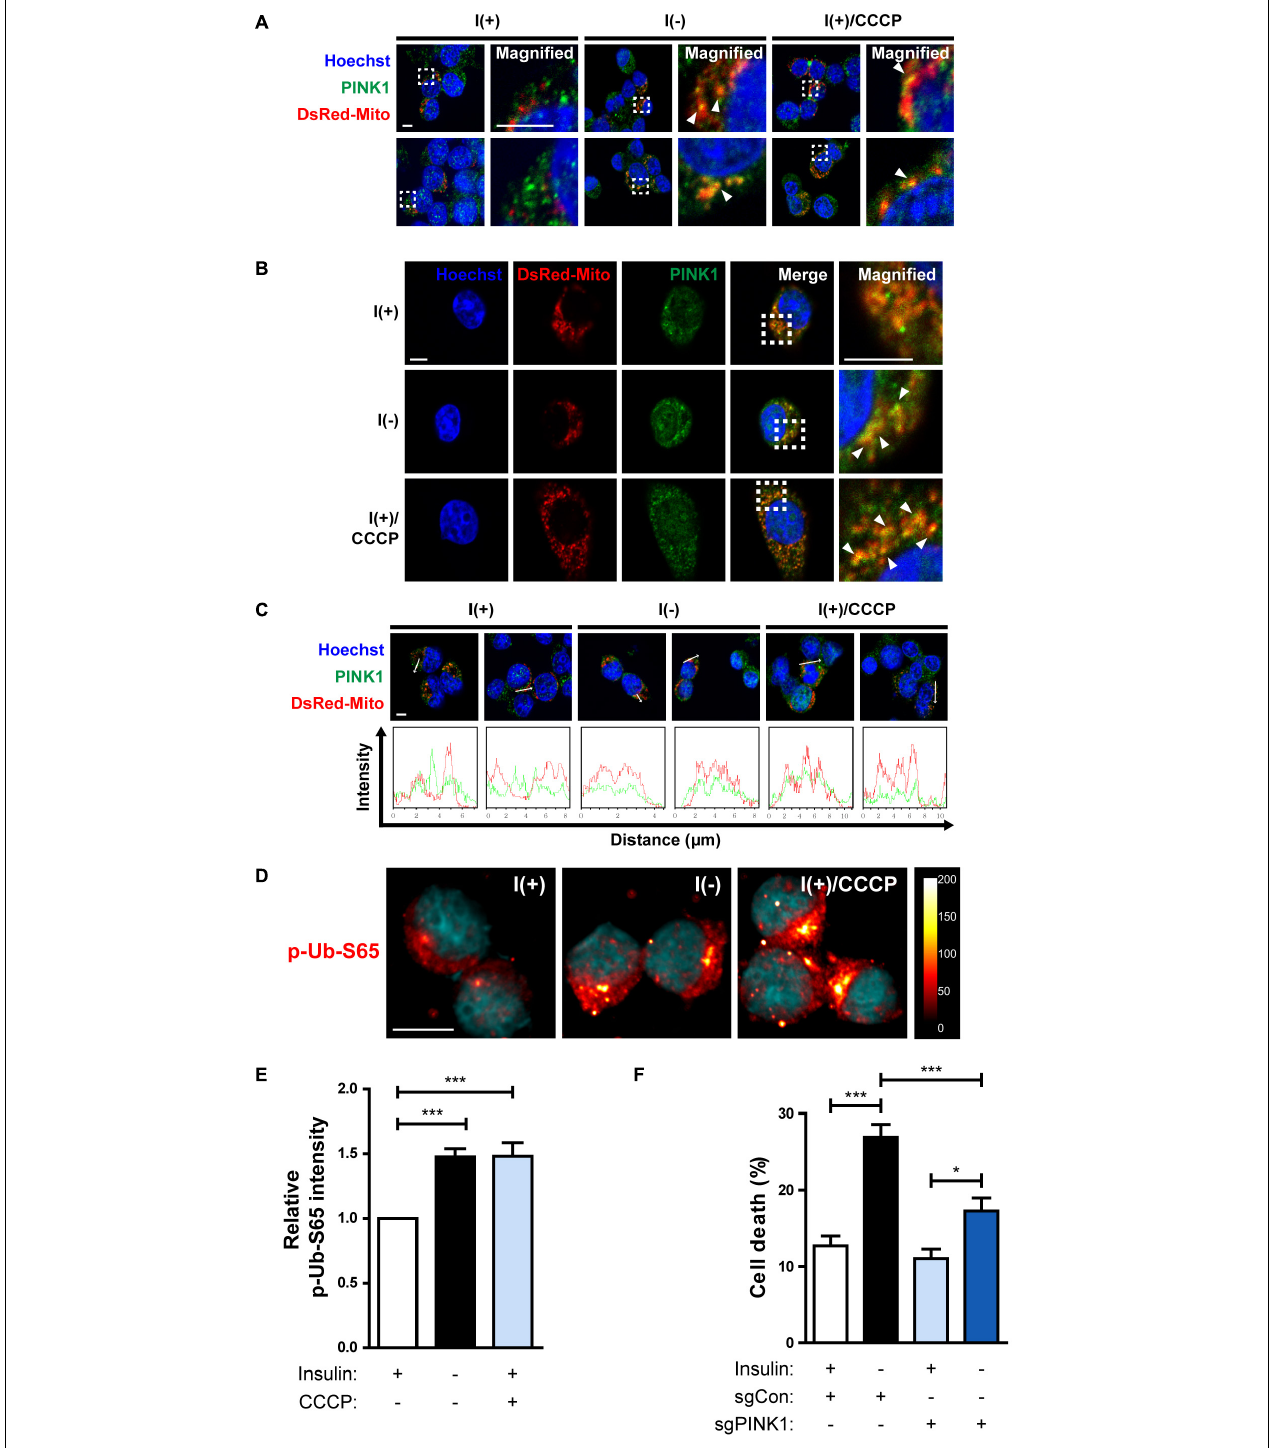
FIGURE 7 | HCN cells undergo PINK1/Parkin-dependent mitophagy following insulin withdrawal. (A,B) An increase in colocalization of PINK1 and mitochondria after insulin withdrawal for 24 h. Arrowheads indicate DsRed-Mito and PINK1 colocalization. Scale bars, 5 µ m. (C) Intensity profile graphs of PINK1 and DsRed-Mito. Scale bar, 5 µ m. (D) An increase in the level of p-Ub-S65 after insulin withdrawal for 24 h. Cells were treated with CCCP (10 µ M) for 0.5 h as a positive control of mitophagy. Blue staining indicates Hoechst, and red staining indicates p-Ub-S65. Intensity is indicated in arbitrary units. Scale bar, 10 µ m. (E) The mean intensity of p-Ub-S65 was quantified using ImageJ software ( n = 33 cells for I( + ), 38 cells for I( − ), 46 cells for I( + )/CCCP from 3 independent experiments). (F) Cell death rates of sgCon and sgPINK1 cells ( n = 4). ∗ p < 0.05, ∗∗∗ p < 0.001.